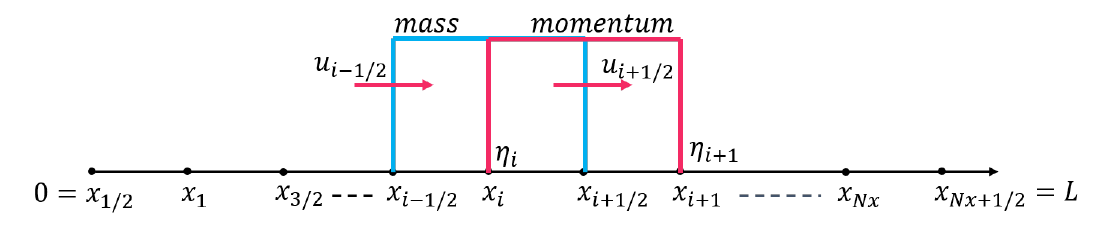
Figure 5. Illustration of staggered grid